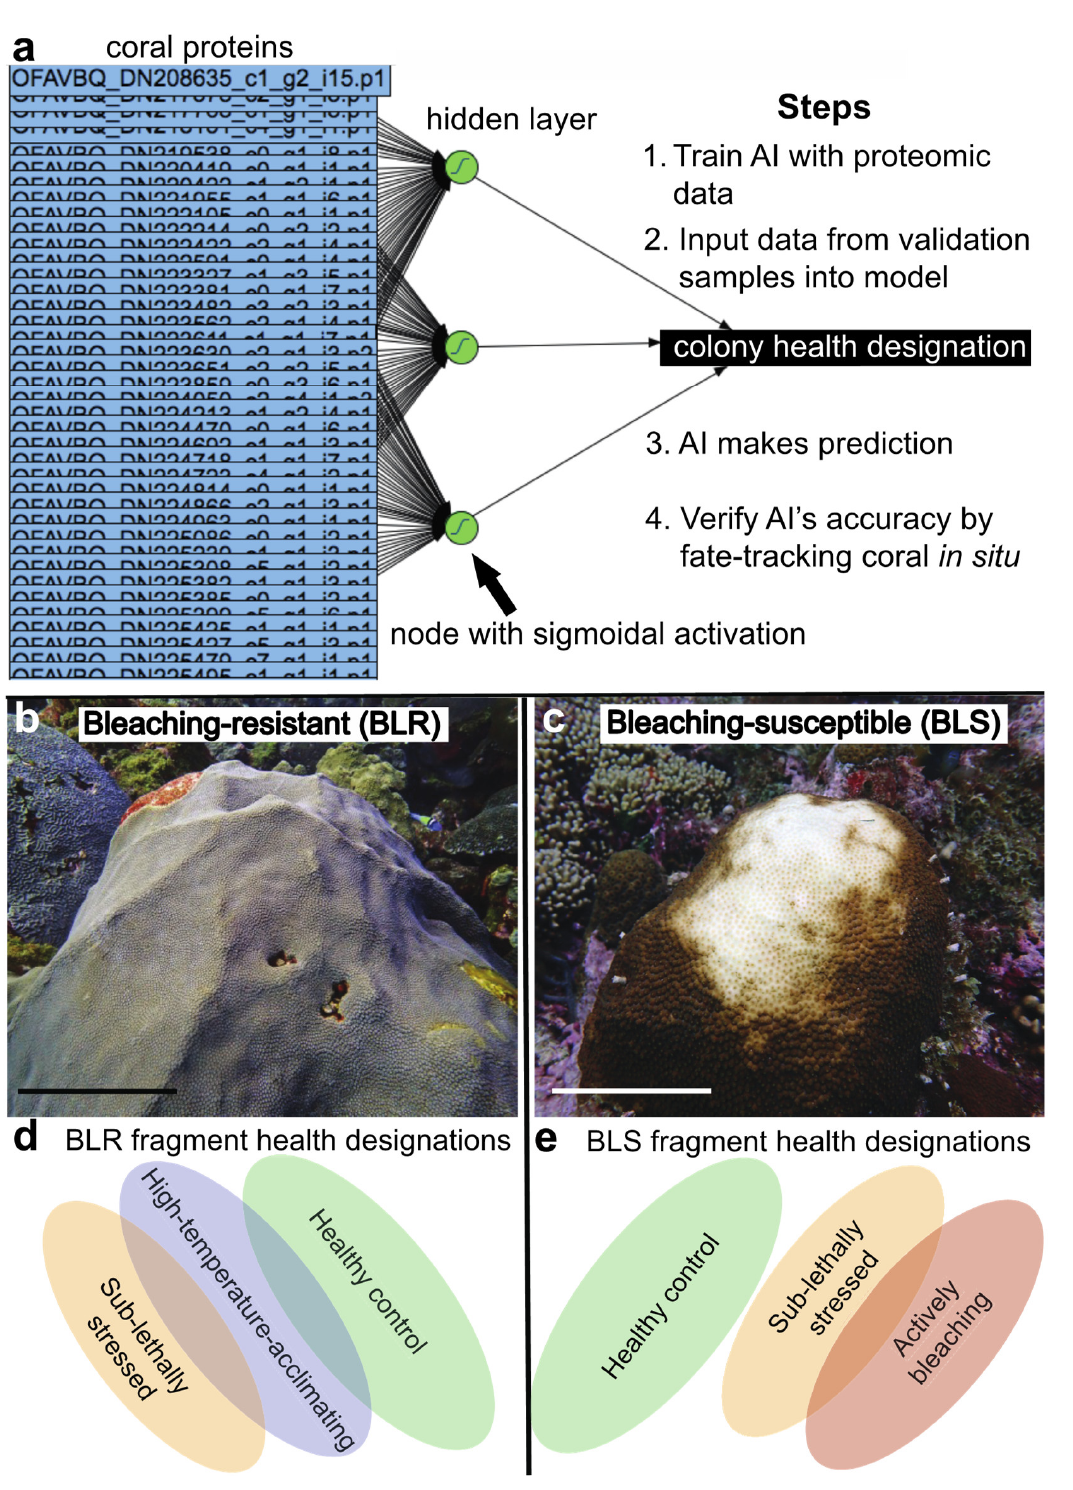
Figure 2. A schematic of the approach and an explanation of key terminology. Note that the neural network of panel a represents a simplified version of model “CHD-lab CHD-lab ( a )” of Table 3. The full accession number is masked for all but the first protein. Representative bleaching-resistant (BLR; ( b )) and bleaching-susceptible (BLS; ( c ) corals imaged in August 2019 have been shown (scales bars represent 30 & 20 cm, respectively). The possible fragment health designations for each colony health designation have been shown as ellipses ( d , e ), respectively), whose degree of overlap is based on hypothetical physiological similarity rather than actual sample sizes (see Tables 1 and 2).